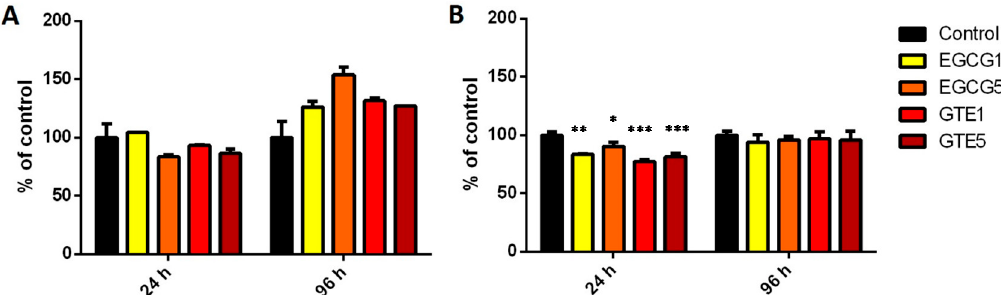
Figure 4. COMT activity in ( A ) proliferating and ( B ) differentiated Caco-2 cells incubated with 1 and 5 µg/mL EGCG and GTE for 24 and 96 h. The bars represent means ± SD of at least three independent measurements. Significance of differences from the control was determined by ANOVA followed by a Dunnett’s test (* p < 0.05, ** p < 0.01, *** p < 0.001).